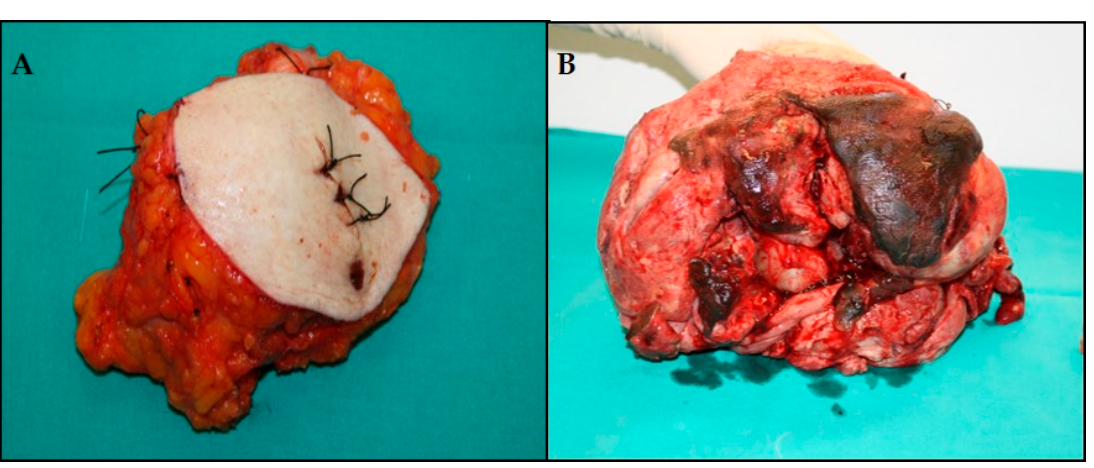
Figure 1. Macroscopic appearance of the bilateral breast PT: ( A ) The right nodulectomy; ( B ) The left mastectomy with necrosis and ulceration of the nipple and the skin.